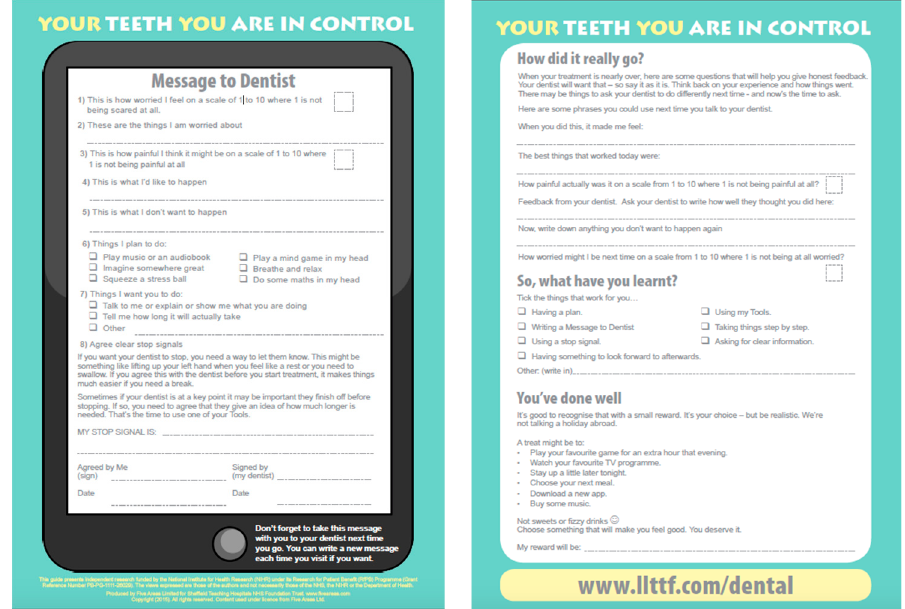
Figure 1. The ‘message to dentist’ proforma, which is given to the child in an A4 2-sided format (a pdf of ‘message to dentist’ is free to download at